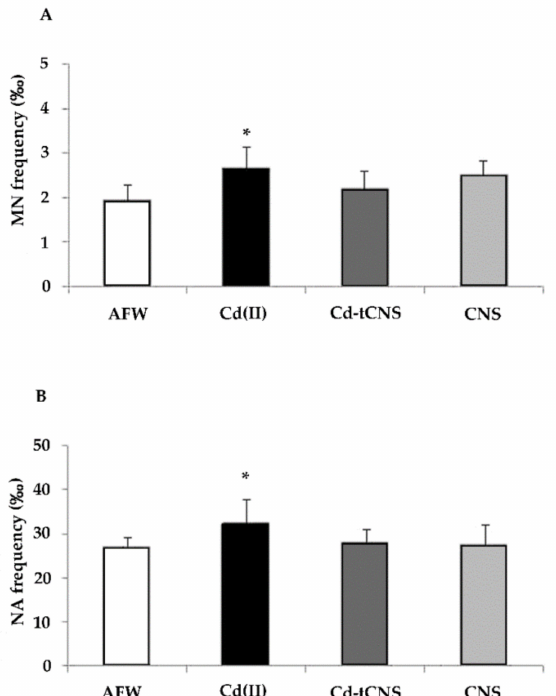
Figure 5. ( A ) Frequencies (% (cid:24) ) of micronuclei (MN) and ( B ) total nuclear abnormalities (NA) in zebra mussel hemocytes after 48 h of exposure to the following experimental groups: AFW (control); Cd(II) (0.05 mg L − 1 of CdCl 2 in AFW); Cd-t CNS (CdCl 2 0.05 mg L − 1 contaminated AFW treated with CNS); CNS (AFW treated with only CNS). Results are shown as mean ± SE. (*) indicates significant di ff erences respect to the control group (AFW) ( p < 0.05).